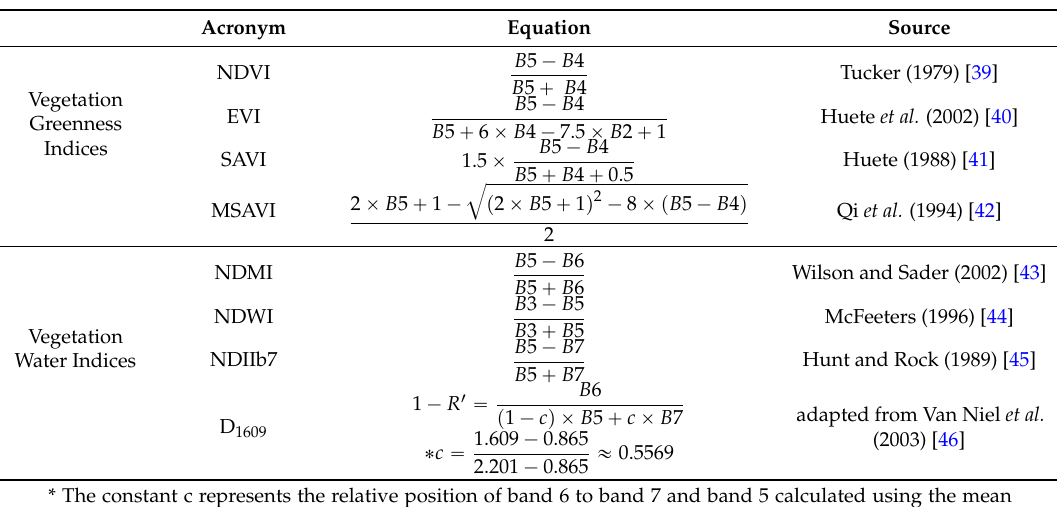
Table 2. Landsat 8 vegetation indices evaluated in this study. Landsat 8 bands: B1 = 0.430–0.45 µ m, B2 = 0.45–0.51 µ m, B3 = 0.53–0.59 µ m, B4 = 0.64–0.67 µ m, B5 = 0.85–0.88 µ m, B6 = 1.57–1.65 µ m, B7 = 2.11–2.29 µ m. Vegetation indices: NDVI = Normalized Difference Vegetation